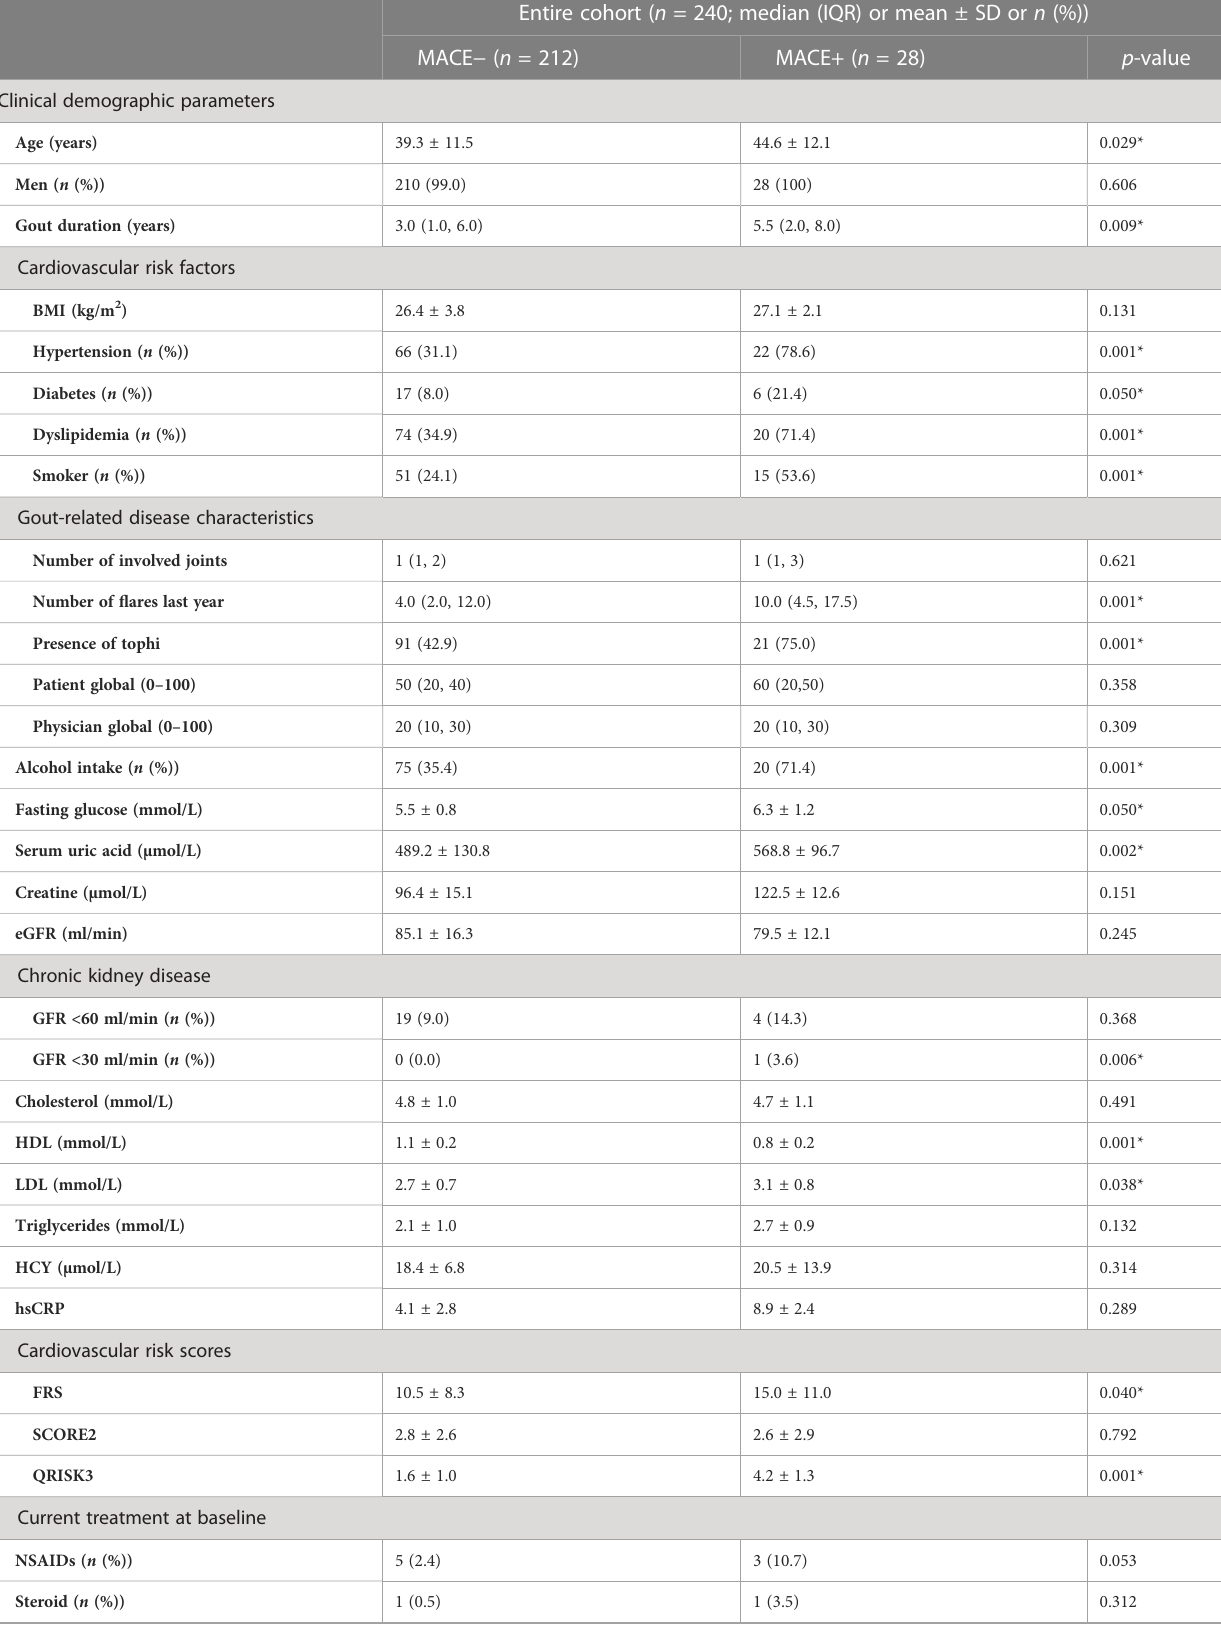
TABLE 2 Clinical characteristics of patients with and without MACE in the entire cohort ( n =